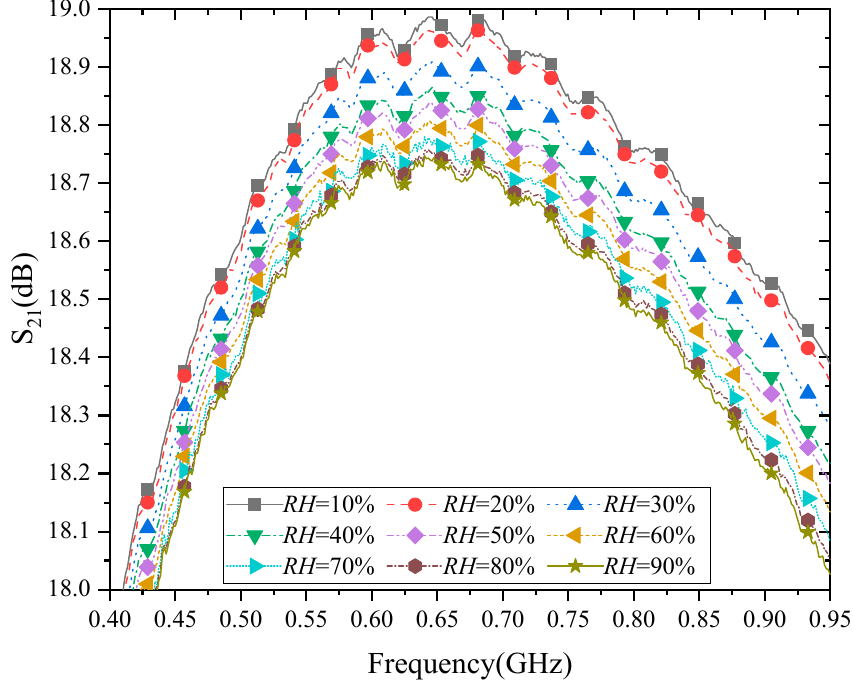
Figure 4. Measured small-signal gain with frequency variations.